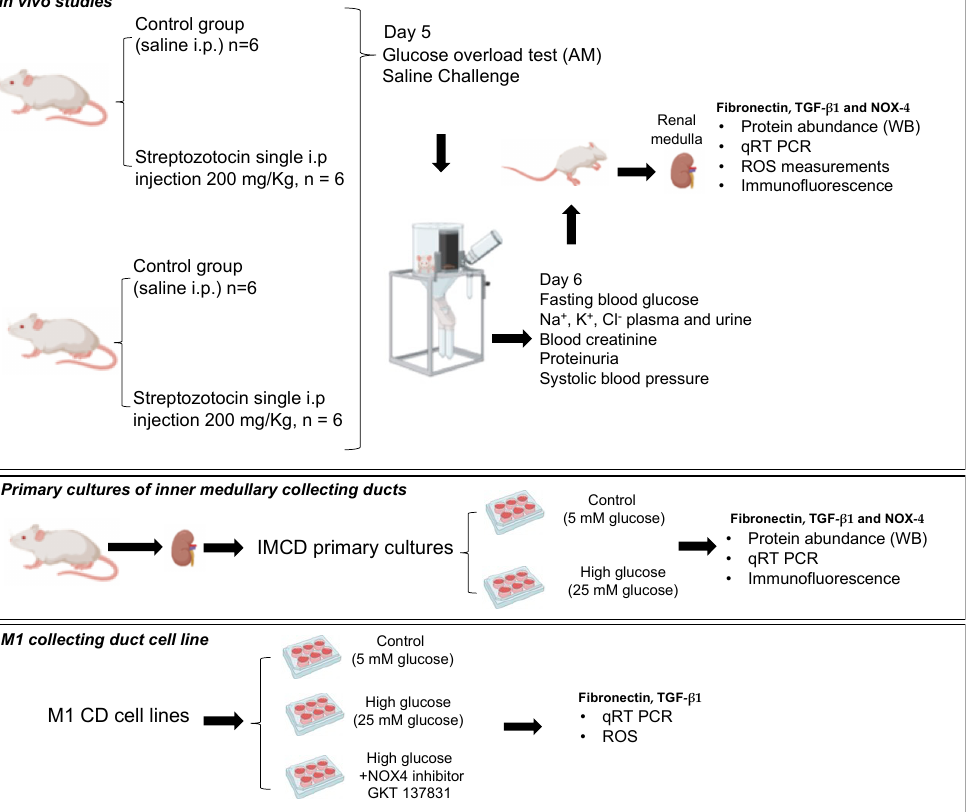
Figure 1. Graphical abstract showing all methods of the study. Three protocols were performed including studies in vivo using streptozotocin-induced type 1 diabetes, in vitro studies using primary cultures of kidney inner medullary collecting ducts treated with normal or high glucose for 48 h, and studies using M1 collecting duct cell line to test the effect of NOX4 inhibitor in conditions of high glucose on NOX4, fi bronectin, and TGF- β 1 expression.